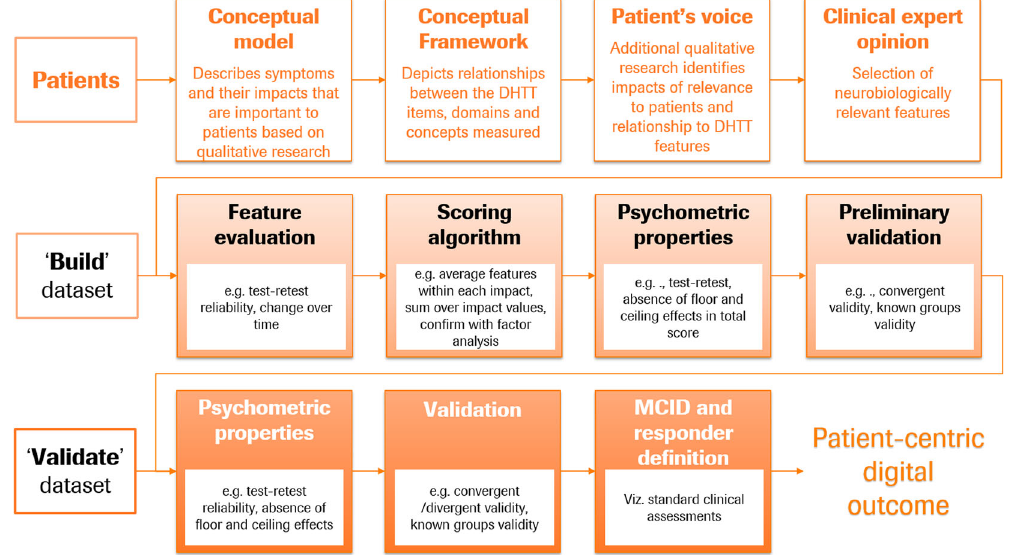
Fig. 3 A roadmap to develop a patient-centric sensor-based outcome measure for an existing DHTT. Patient input provides the foundation for the development of this outcome measure. A conceptual model describes symptoms and impacts that are important to patients. A conceptual framework depicts the relationships between the concepts measured via the DHTT and associated items and domains. Additional qualitative research seeks to establish the impacts relevant to patients and their relationships with the DHTT features. Clinical expert opinions are required to ensure that the features represented in the fi nal conceptual framework are neurobiologically relevant. The ensuing stages of outcome development require two independent datasets: the build dataset is used to select statistically robust and appropriate features, build a scoring algorithm, con fi rm psychometric properties of the scoring algorithm, and provide a preliminary validation; the independent validate dataset con fi rms the robustness of the psychometric properties, provides further validation data related to the DHTT outcome measure, and generates minimally clinically important difference (MCID) estimates and responder de fi